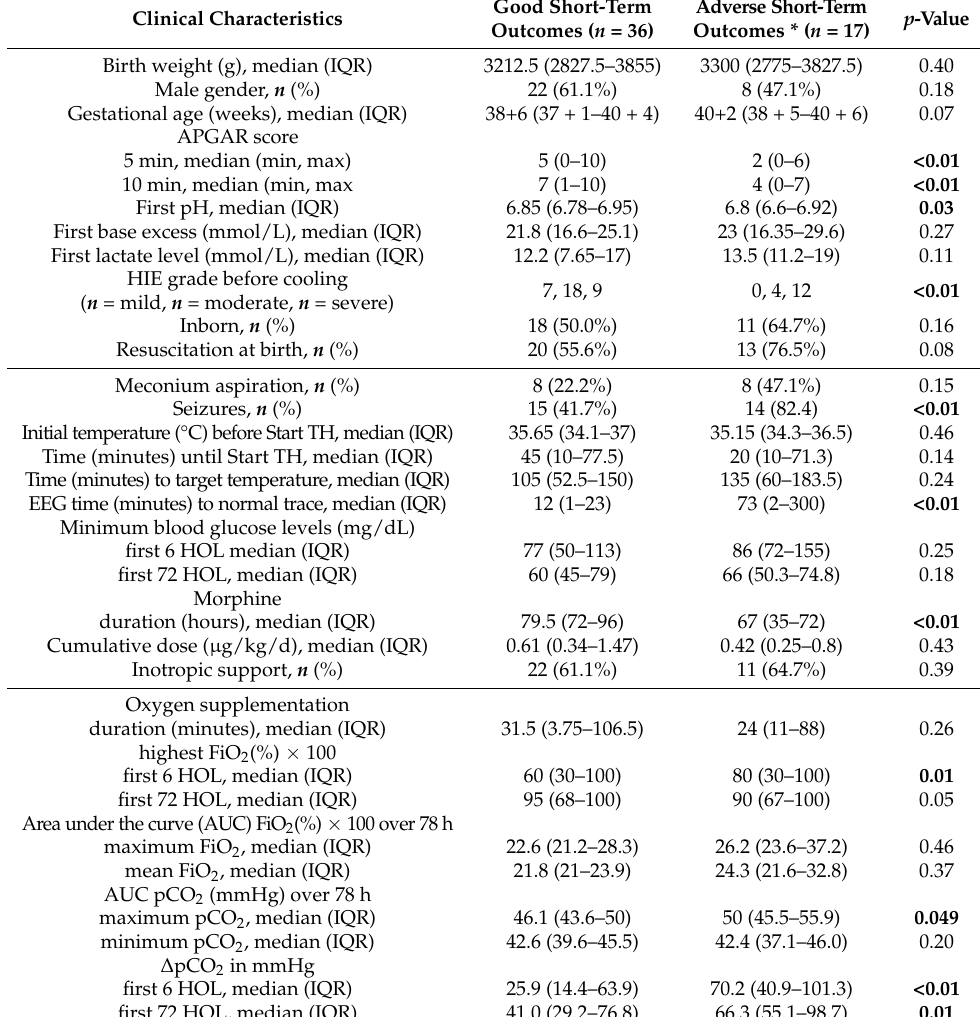
Table 2. Descriptive data of the intubated cooled asphyxiated neonates according to short-term outcome. Data are presented as median and